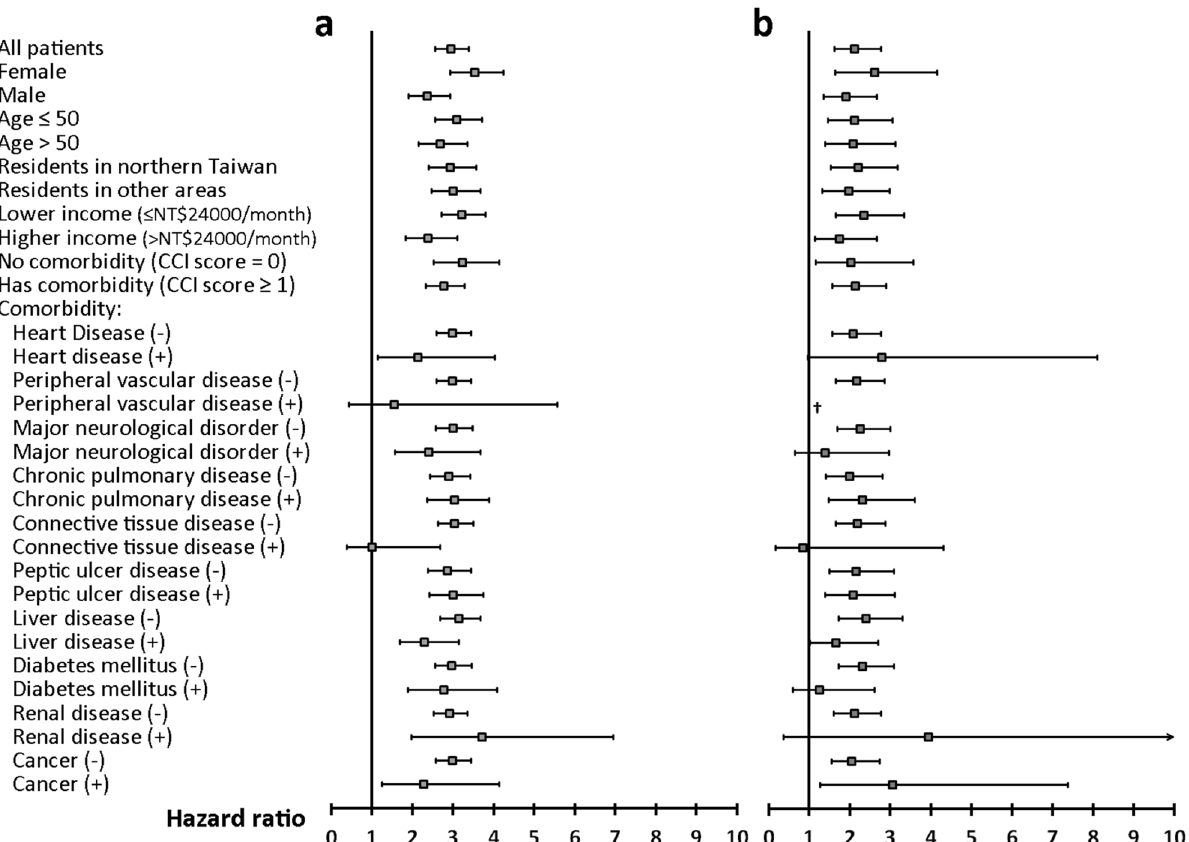
are adjusted for sex, age, residency, income level and the presence of various comorbidities (except for the variable used for stratification). ( a ) Study arm A (suspected sleep apnea patients and control A subjects); ( b ) study arm B (probable sleep apnea patients and control B subjects). * SA sleep apnea, CCI Charlson Comorbidity Index, HR hazard ratio, CI confidence interval. † Due to small sample size, hazard ratio cannot be